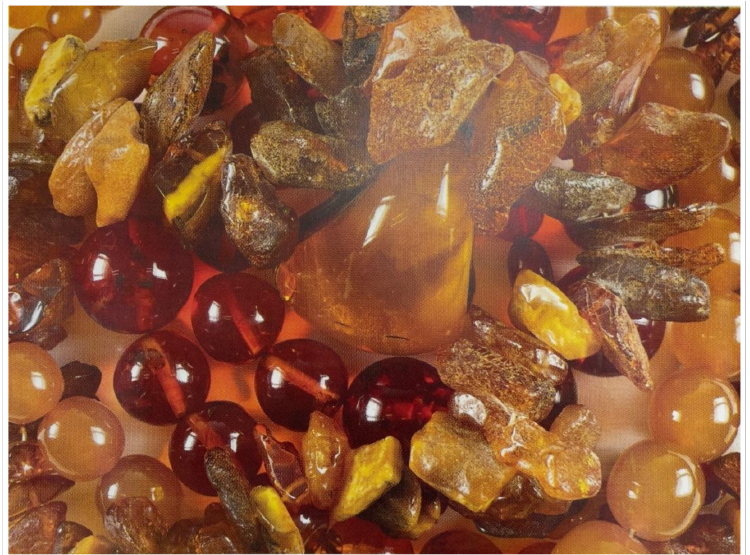
Figure A3. 25LPI, offset litho, CMYK inks, printed Y,M,C,K, white Plike, film positive, print size: 600 mm × 450